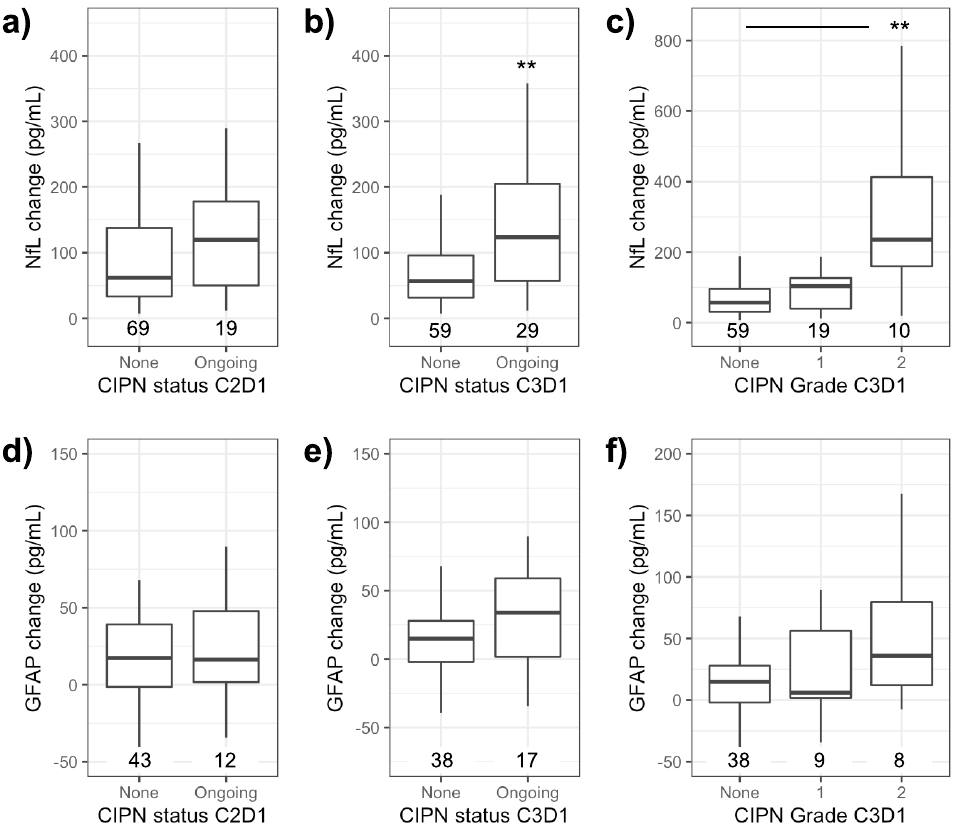
Figure 4. Serum NfL at C2D1 is elevated in subjects reporting CIPN at C3D1 but not C2D1. ( a ) NfL change at C2D1 in subjects with ongoing CIPN at time of sample collection. ( b ) NfL change at C2D1 in subjects with ongoing CIPN at day 1 of cycle 3 (C3D1). ( c ) NfL change at C2D1 by CIPN grade on C3D1. ( d ) GFAP change by CIPN Status at C2D1 or ( e ) C3D1 or ( f ) highest grade of ongoing CIPN at C3D1. ** p < 0.01 by Wilcoxon rank sum test panel ( a , b , d , e ) or Dunn’s test panel ( c ) and ( f